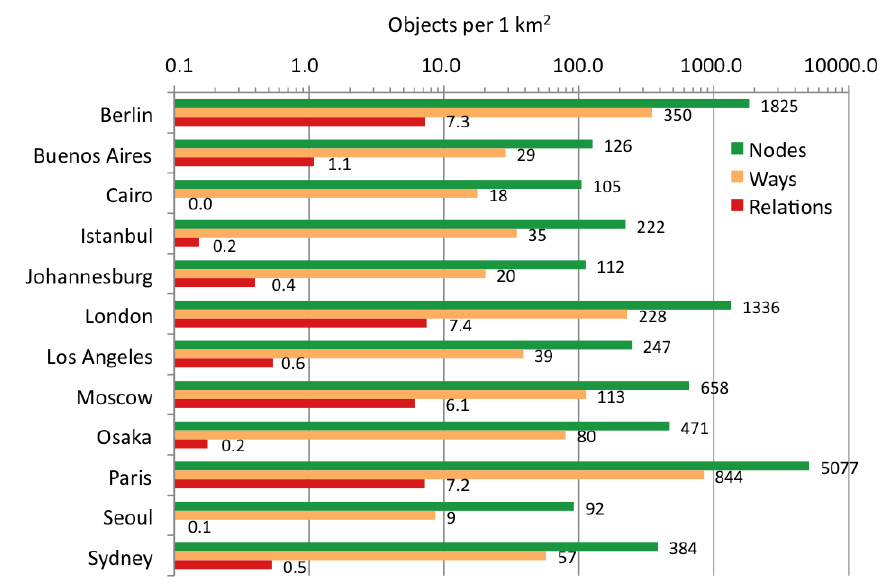
Figure 5. Density of nodes, ways & relations per km 2 (Oct.